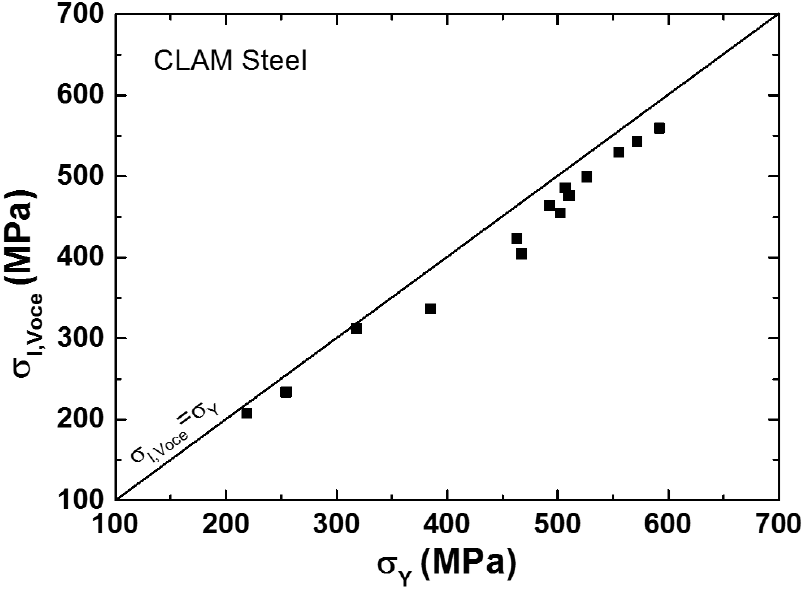
Figure 10. Comparison of initial stress ( 𝜎 𝐼,𝑉𝑜𝑐𝑒 ) and true yield strength ( 𝜎 𝑌 ) at different temperatures in China low activation martensitic (CLAM) steel.